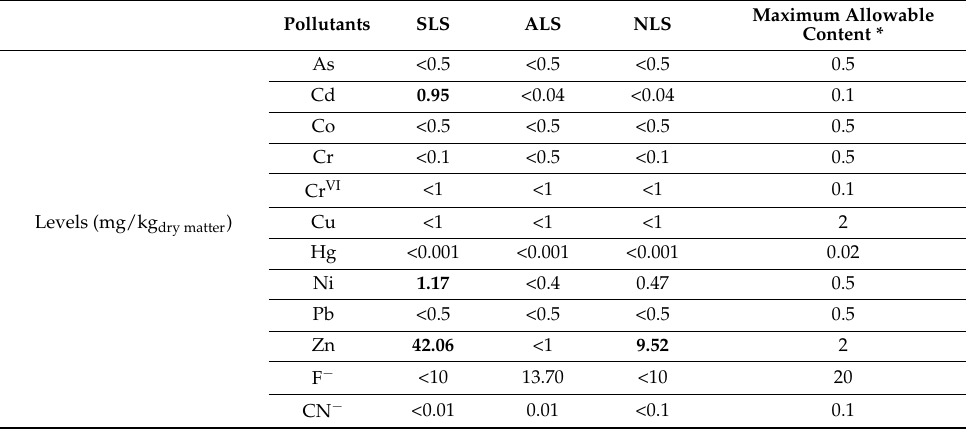
Table 6. Leached inorganic pollutant levels for the three studied sediments compared to the thresholds specified in